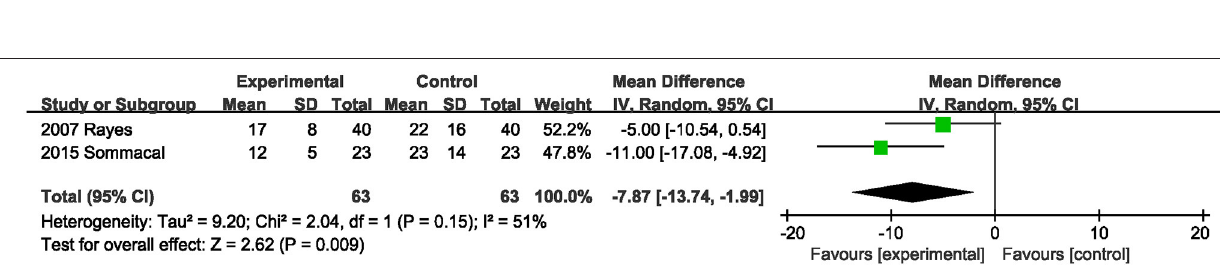
FIGURE 5 | Effect of probiotics or synbiotics supplementation on the incidence of delayed gastric emptying.